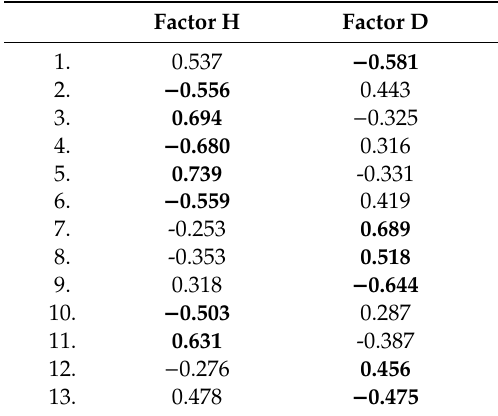
Canine behaviours (Table 3), human verbal cues (Table 4) and human body languages (Table 5) were coded using ethograms developed by referring to previous research [13,24,30–33] and modified during practice sessions. Behaviours were coded as ‘point events’ or ‘state events’. A point event indicates the number of times the event was observed and a state event was defined as the duration of the observed